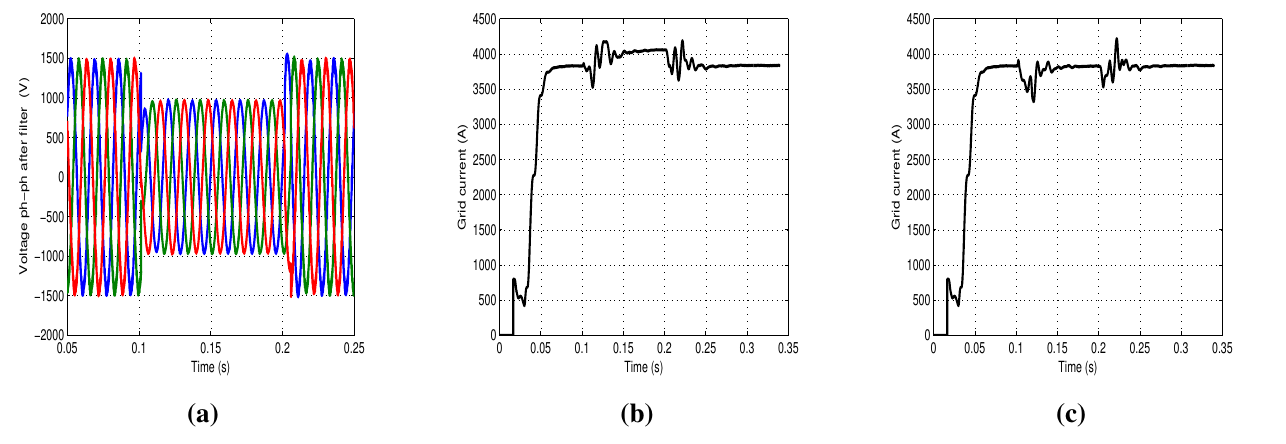
Figure 5. Effect of the dynamic current limit: voltage dip with amplitude − 38% . ( a ) Voltage dip considered from t = 0 . 1 s till t = 0 . 2 s; ( b ) RMScurrent phase without a dynamic limit; ( c ) RMS current phase with a dynamic